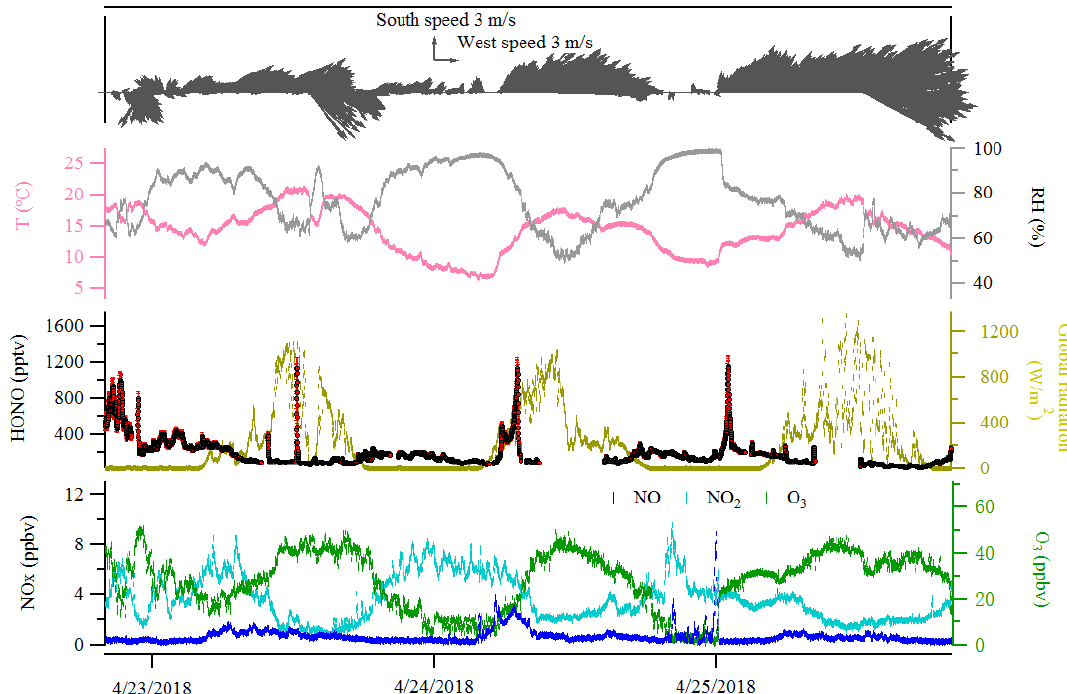
Figure 5. Case events for HONO (LOPAP) and related species at Melpitz site during the day from 23 to 25 April 2018. The red color in the HONO panel indicates the measurement error of HONO